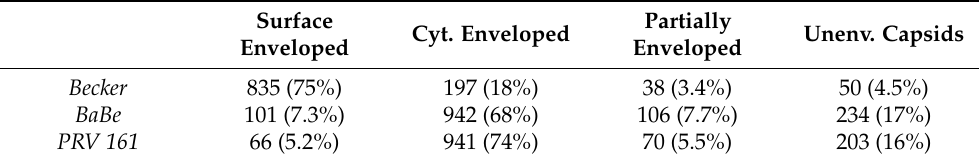
Table 2. Cytoplasmic and cell surface forms of PRV particles associated with hippocampal neurons . Surface Partially Cyt. Enveloped Unenv. Capsids Enveloped Enveloped Becker 835 (75%) 197 (18%) 38 (3.4%) 50 (4.5%) BaBe 101 (7.3%) 942 (68%) 106 (7.7%) 234 (17%) PRV 161 66 (5.2%) 941 (74%) 70 (5.5%) 203